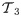
The transformation T3 in the proof of Proposition 25.